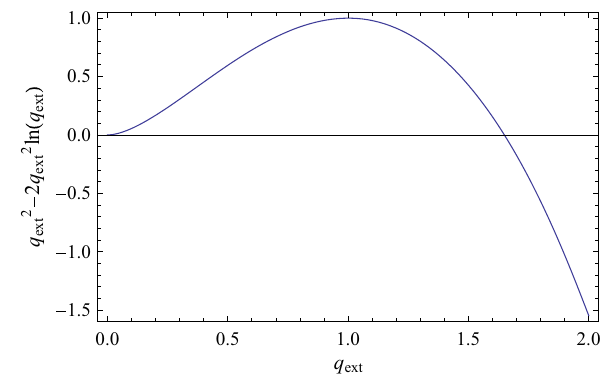
Fig. 1 The behavior of the left-hand side of Eq. (14) versus q . There is a maximum at q ext = 1